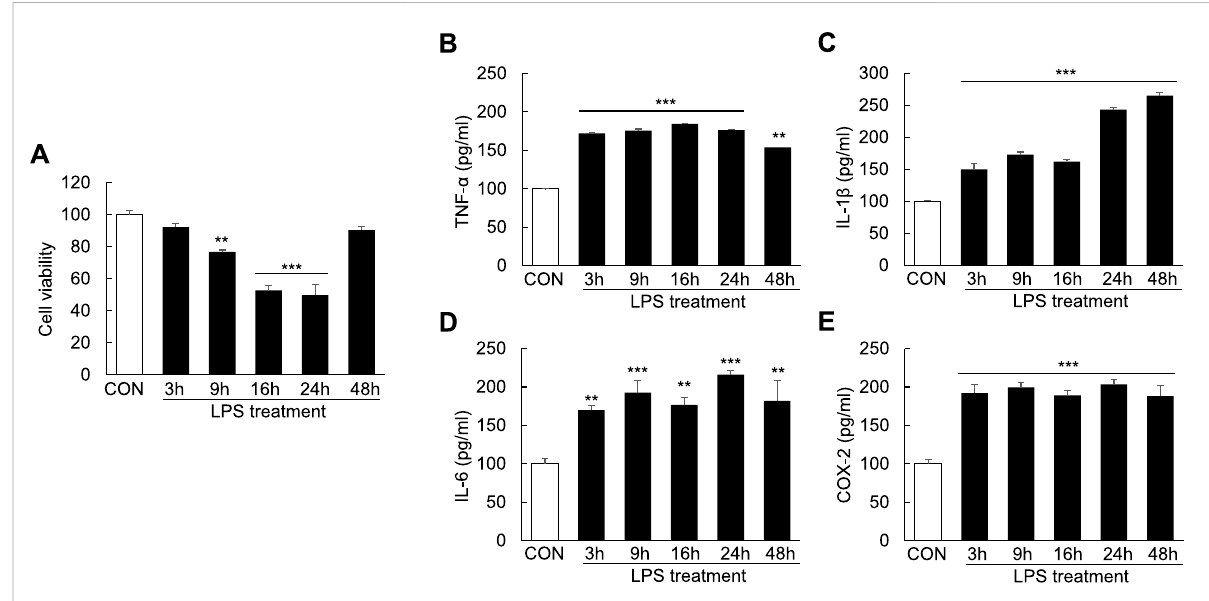
FIGURE 5 Induction of cell apoptosis and proin fl ammatory cytokines in LPS-induced Huh7 cells. Huh7 cells were treated with LPS (1000 ng/ml) for 3, 9, 16, 24, and 48 h. MTT assay (A) and ELISA (B – E) were conducted 24 h after LPS treatment. ** p < 0.01, *** p < 0.001 vs.